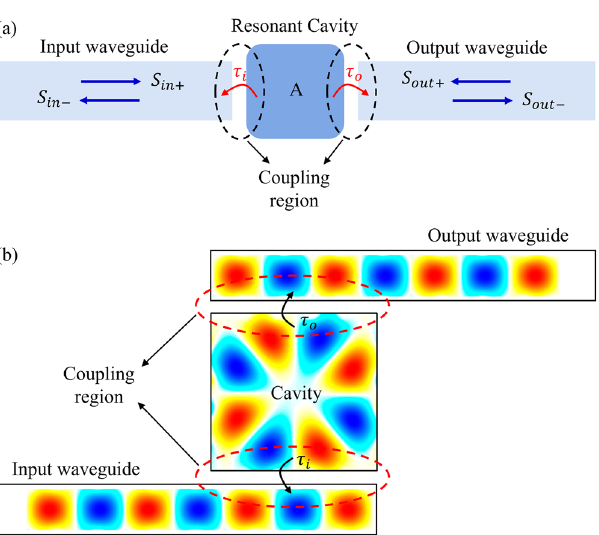
Figure 4. ( a ) Schematic of a coupled waveguide-cavity-waveguide system for the coupled-mode theory. ( b ) Schematic of the light coupling mechanism for the proposed hybrid P-PhC RI sensor